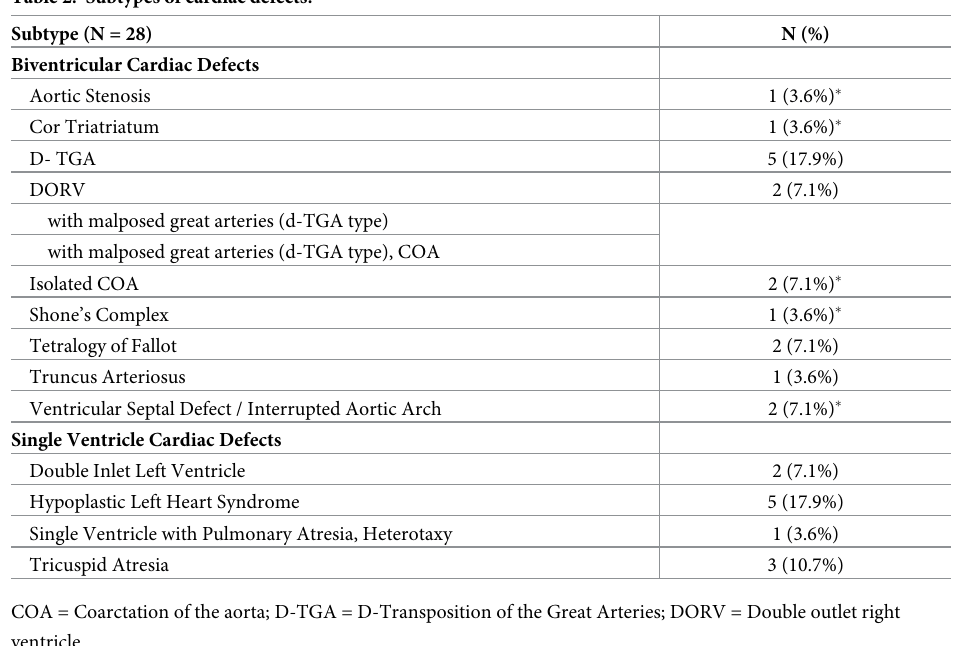
Table 2. Subtypes of cardiac defects.